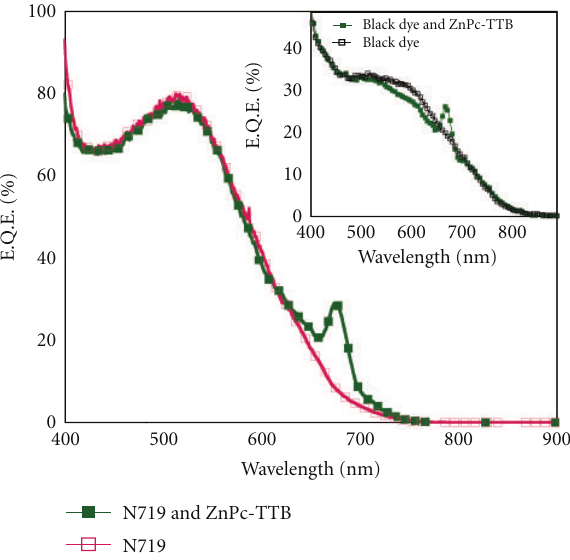
Figure 19: Action spectrum of nanowire solar cell comprising N-719-coated rutile as acceptors, with and without ZnPC-TTB molecules in electrolyte as the donors. Inset shows action spectrum for black-dye-coated rutile acceptors with and without ZnPc-TTB donors. Ten percent of data points are shown. Reprinted with permission from